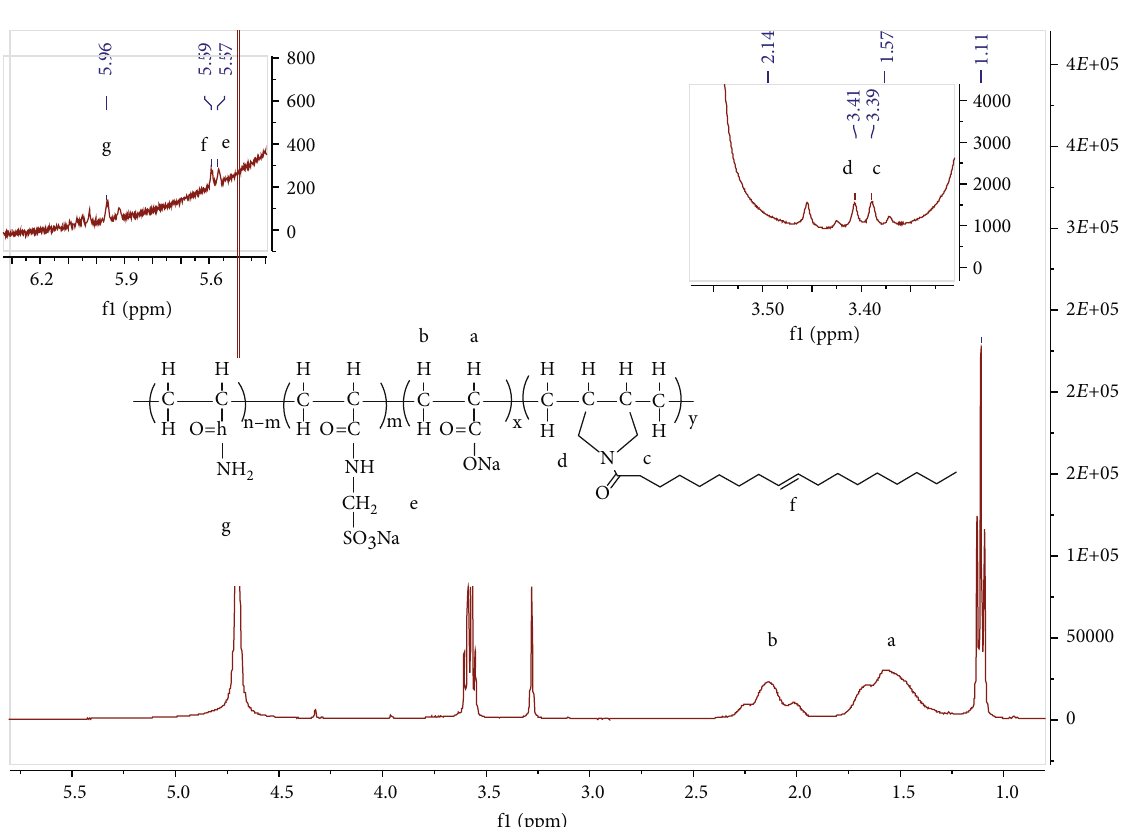
Figure 2: IR spectra of HPDN and HPDS.